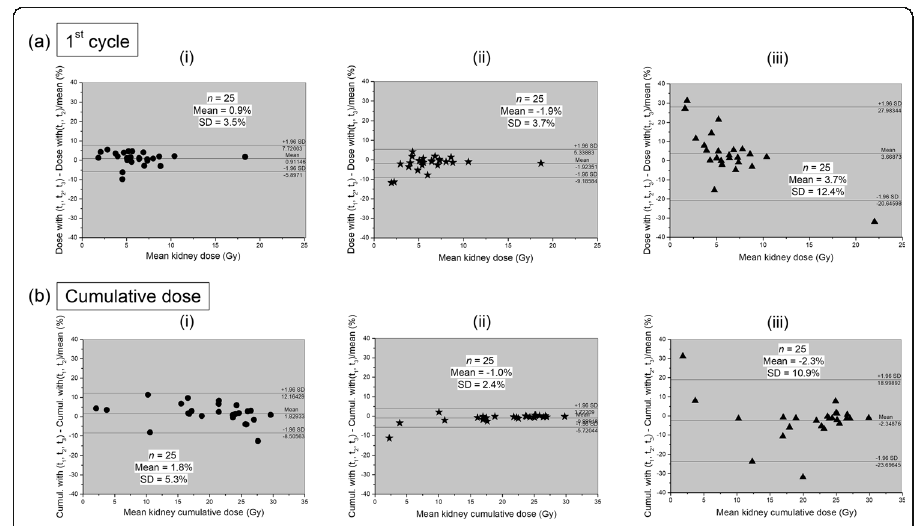
Fig. 4 Bland and Altman plots showing differences in the kidney-absorbed dose a after the first PRRT cycle and b after completion of the treatment, computed using the standard protocol and the “ 2 time-points ” (i) ( t 1 , t 2 ), (ii) ( t 1 , t 3 ), or (iii) ( t 2 , t 3 ) protocols, with 95% limits of agreement (mean± 1.96